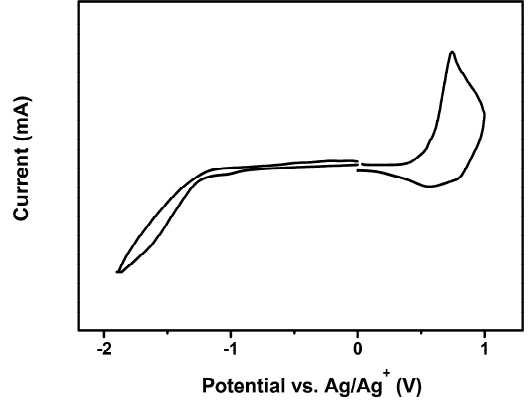
Figure 1. UV–vis absorption spectra of PSTDPP in 1 × 10 − 5 M chloroform solution and at solid state.